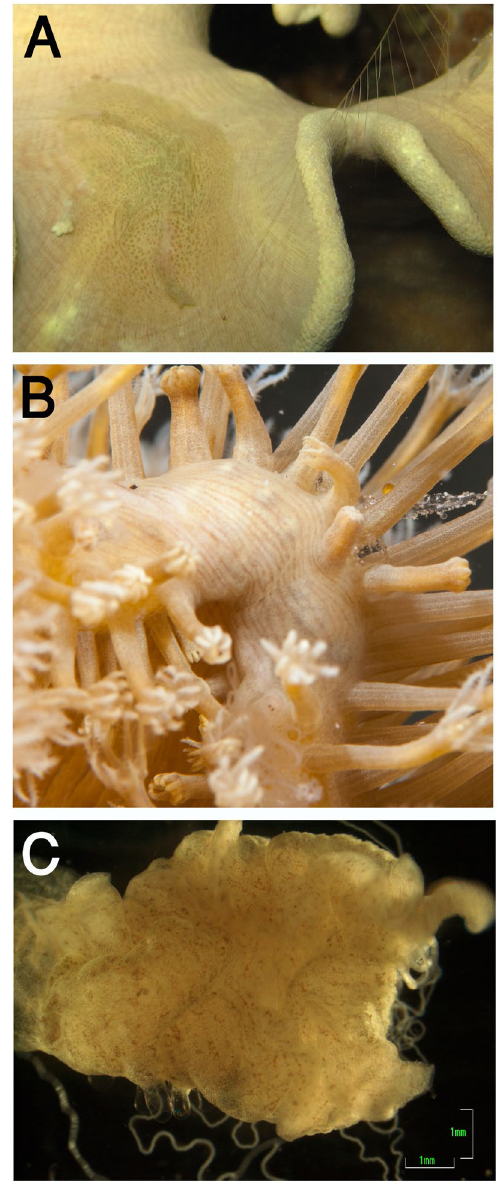
Figure 6. Benthic ctenophore species from the lineolata / punctata clade ( A ) Coeloplana punctata on its host, the soft coral Sarcophyton , in the Gulf of Aqaba, Red Sea; ( B ) Coeloplana lineolata on its host, the soft coral Sarcophyton ; ( C ) A specimen originally assigned as “brown dots” or Coeloplana sp. 1, as it was challenging to identify based on morphology, which comprises of both brown dots and a somewhat parallel lines pattern. Photos credit: Eran